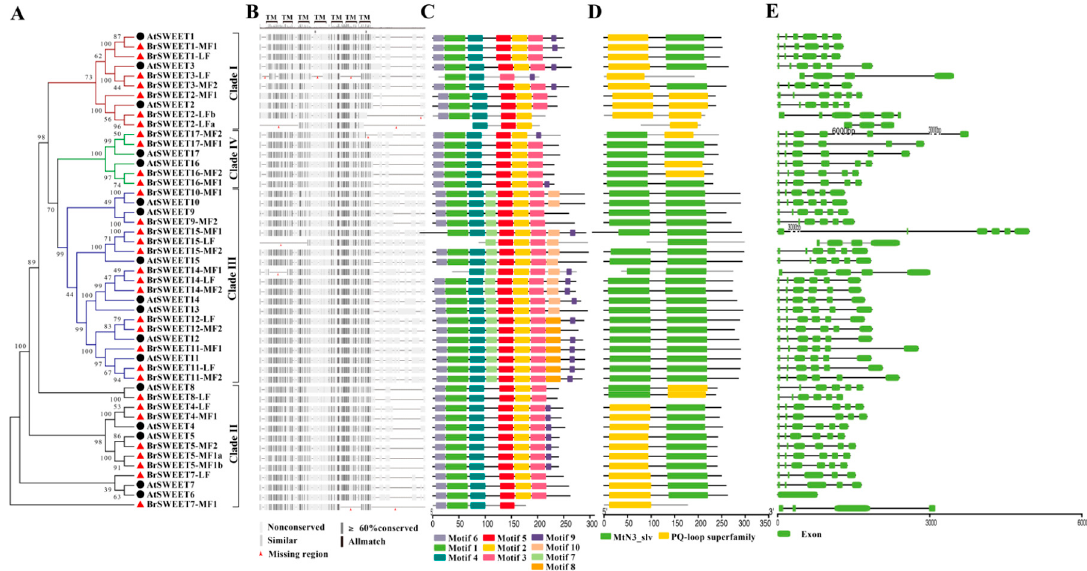
Figure 3. SequencefeatureanalysisofSWEETsin A.thaliana and B.rapa . ( A )NJ-phylogeneticrelationship, Figure 3. Sequence feature analysis of SWEETs in A. thaliana and B. rapa . ( A ) NJ-phylogenetic ( B ) sequence alignment of amino acid, ( C ) conserved motif, ( D ) conserved domain, and ( E ) exon-intron relationship, ( B ) sequence alignment of amino acid, (C) conserved motif, ( D ) conserved domain, and structure. The seven transmembrane ™ domains were assigned a sequence alignment based on the ( E ) exon-intron structure. The seven transmembrane™ domains were assigned a sequence alignment AtSWEET1 structure indicated by Tao et al. based on the AtSWEET1 structure indicated by Tao et al. [4].